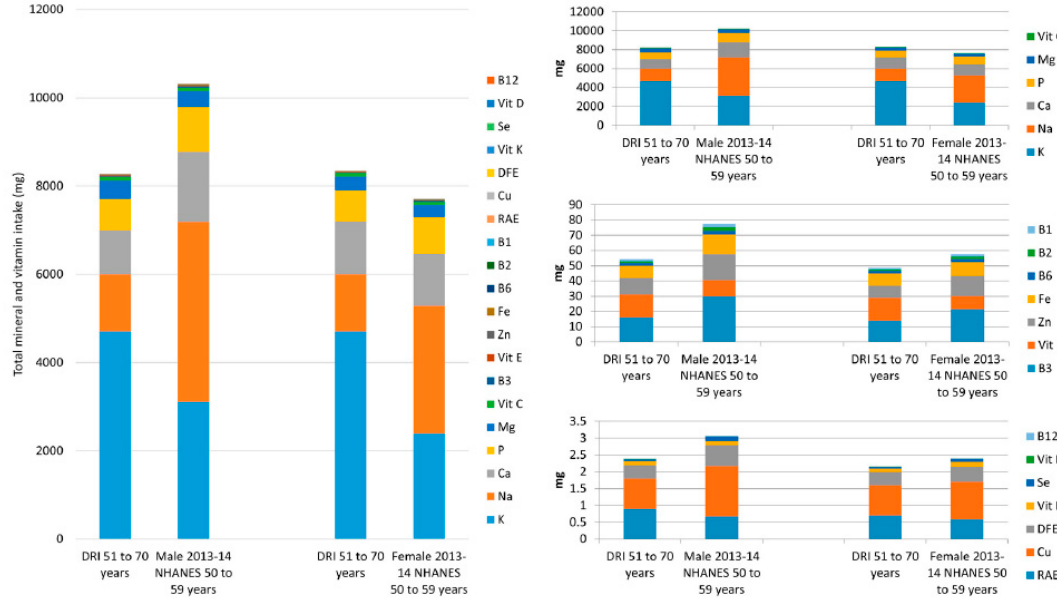
Figure 3. Male and female, aged 50–59 years, mean daily mineral and vitamin intakes from food, from National Health and Nutrition Examination Survey (NHANES) 2013–2014 data versus the DRI. The large figure includes all the minerals and vitamins combined; the smaller figures to the right contain smaller numbers of micronutrients for detail. Abbreviations: Abbreviations: calcium (Ca),